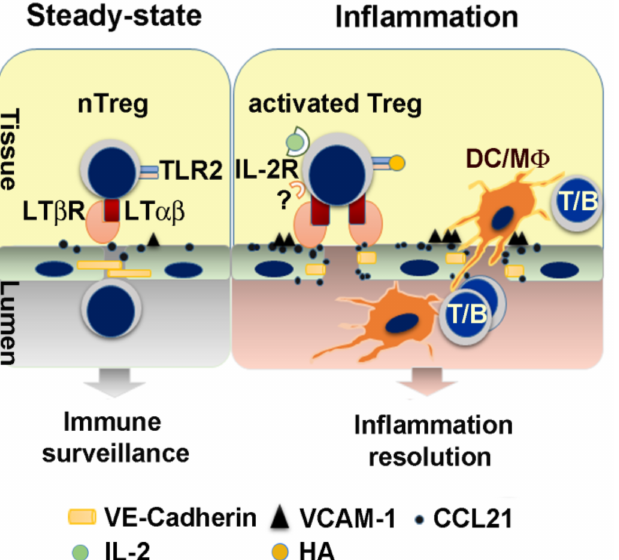
Figure 4. Treg license LEC via LT α 1 β 2-LT β R to facilitate other immune cell lymphatic